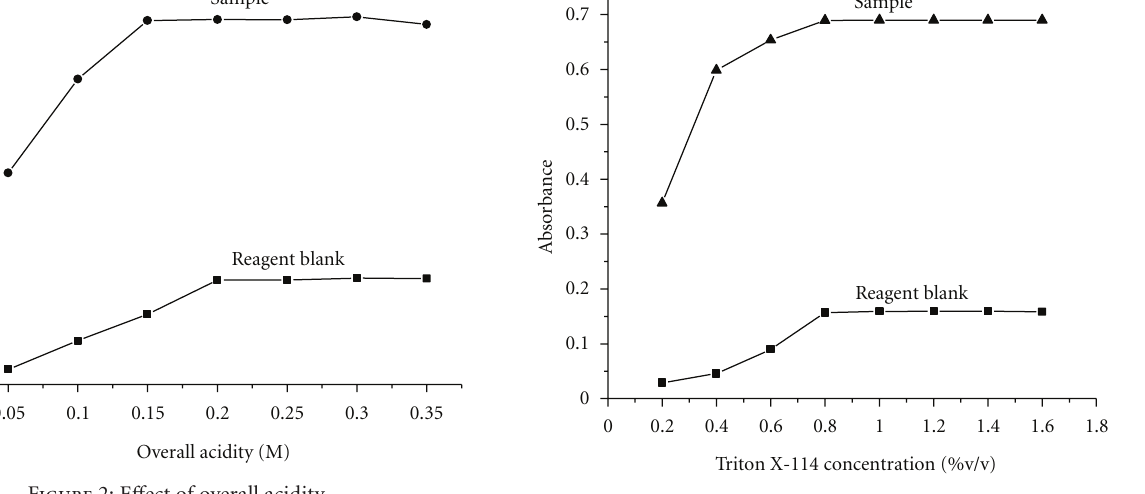
Figure 3: E ff ect of Triton X-114 concentration.